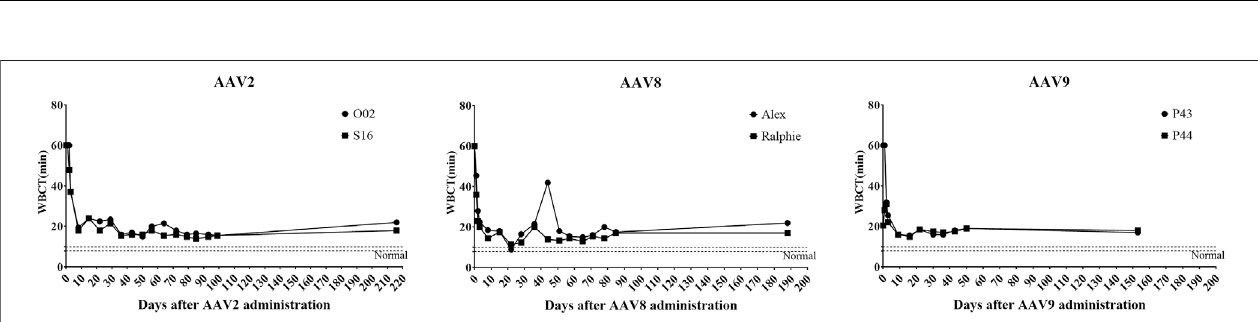
FIGURE4| Whole-bloodclottingtime(WBCT)inhemophiliaBdogafteradministrationofAAV2,AAV8orAAV9vectors.HemophiliaBdogsreceived1×10 12 vg/kg of AAV2, AAV8 or AAV9 packaged with a cFIX-opt-R338L transgene. Blood was collected at different timepoints. The baseline of WBCT in hemophilic dogs is over 20 min. A range of 6 – 12 min in normal dogs has been indicated in the box region as